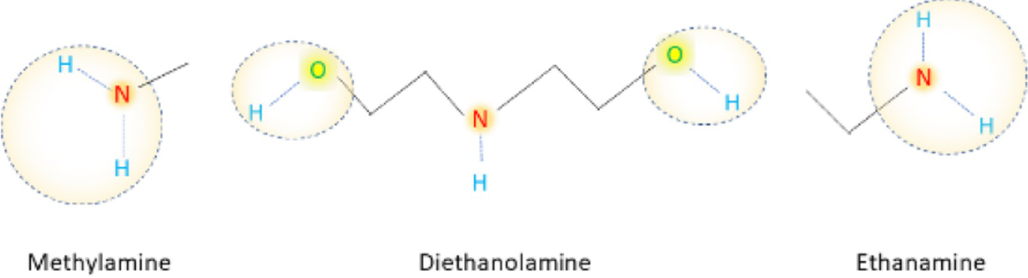
Fig 2. Main functional groups in methylamine, diethanolamine, and ethanamine, respectively participating in the reduction of metal ions into nanomaterials.